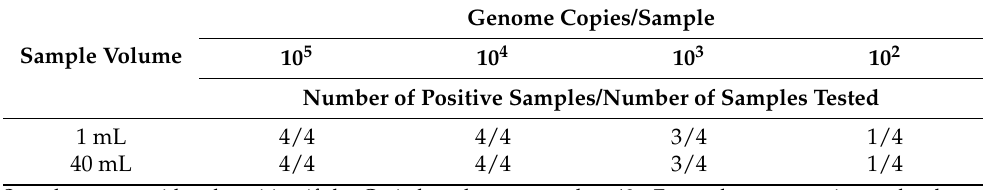
Table 1. Detection of the HAV using capture by ApoH beads in CV-1 buffer.